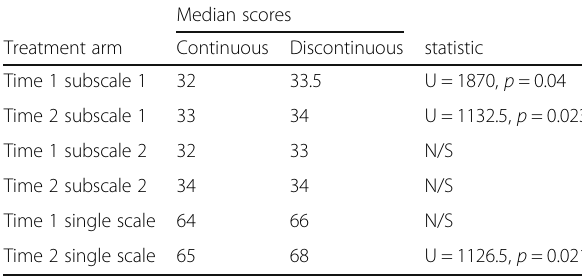
Table 6 Comparison of subscale and single-scale scores between continuous and discontinuous arms at times 1 and